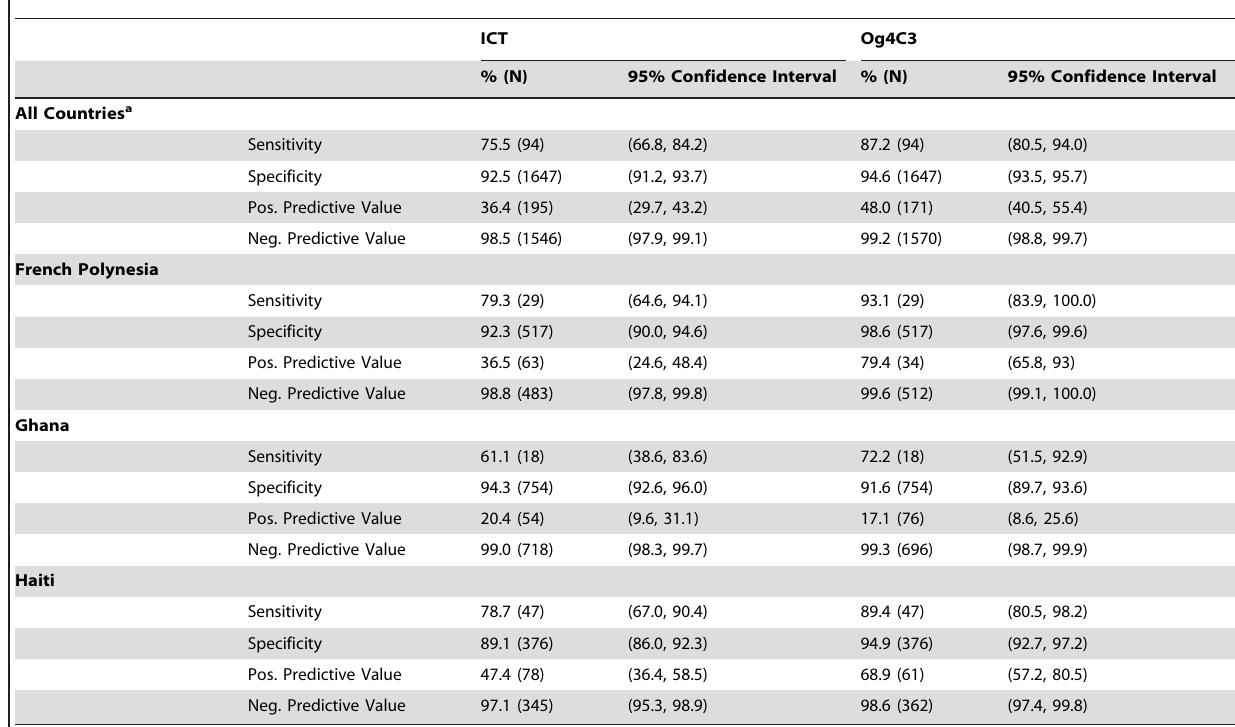
Table 13. Sensitivity, specificity, and predictive values for antigen